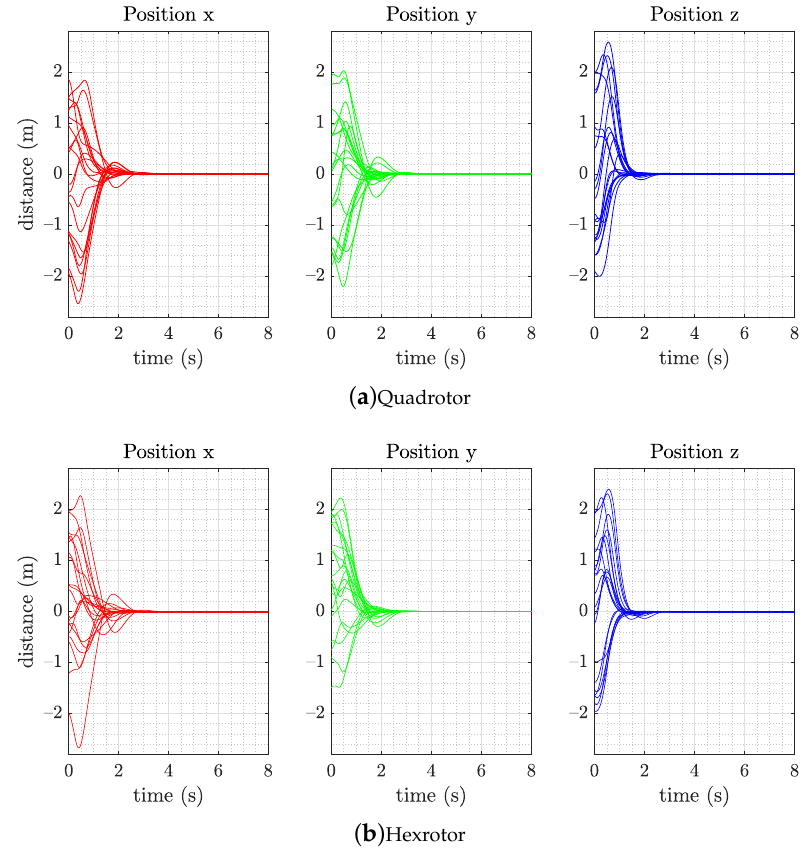
Figure 8. Simulation response of the ( a ) quadrotor and ( b ) hexrotor models, which achieved hovering capability within 8 s with 20 random initial states in the simulation flight test (position, velocity, attitude, and angular